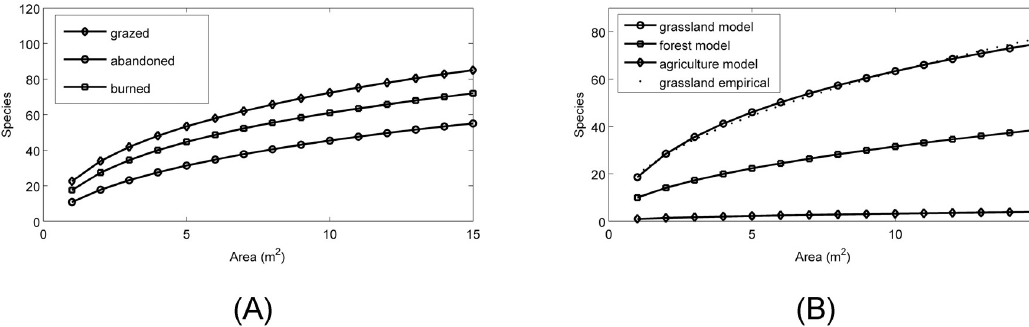
Fig 1. Species-area relationships (SARs). (A) Empirical SARs for the different subcategories of grassland that were sampled in Aparados da Serra National Park, Rio Grande do Sul, Brazil. (B) Grassland SAR (circle), forest SAR (square), and agriculture SAR (diamond) fitted to empirical data and used to parameterize the model. The arithmetic mean of the empirical SARs (dotted) of the subcategories of grassland (shown in (A)) is shown for comparison purposes. See Species-area relationships subsection for details on data